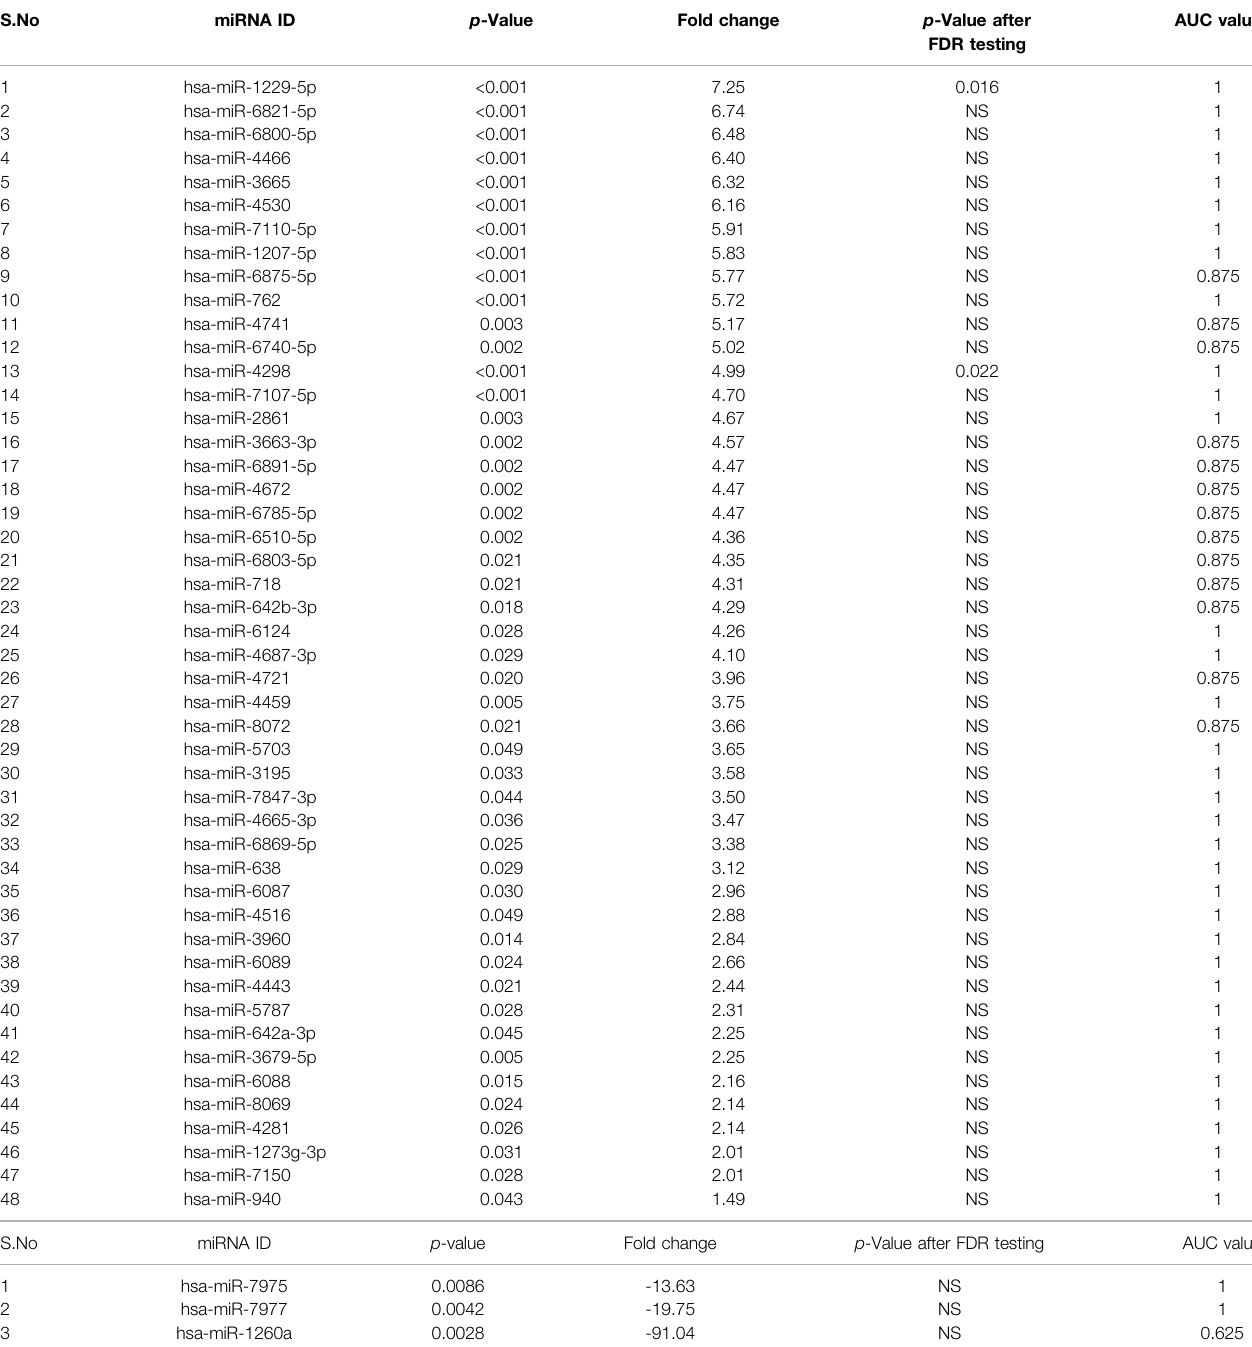
TABLE 2 | (A) Signi fi cantly up-regulated miRNAs in tears of children with VKC in comparison to controls. (B) Signi fi cantly down-regulated miRNAs in tears of children with VKC in comparison to controls.